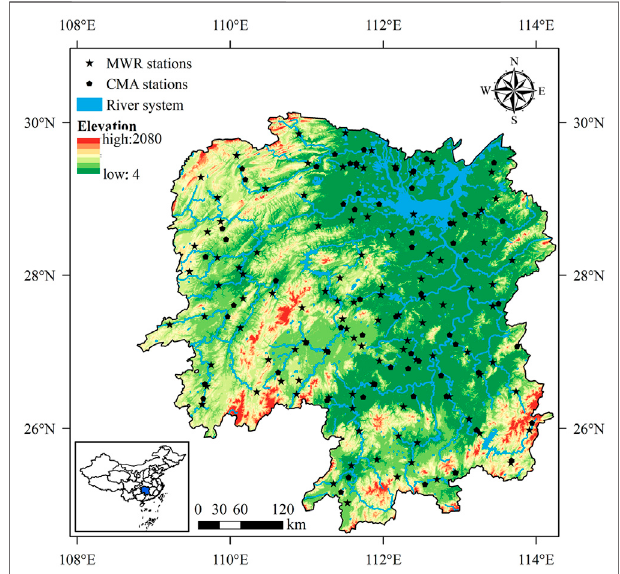
FIGURE1| Distributionmapoftopographical,drainage,andautomated soil moisture observation stations in Hunan province.